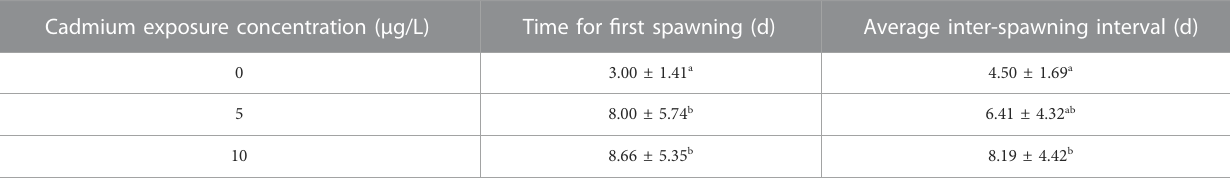
Data are expressed as mean ± SD. Same superscript letters between Cd-exposed group and the control group in the same column are not signi fi cantly different ( p >